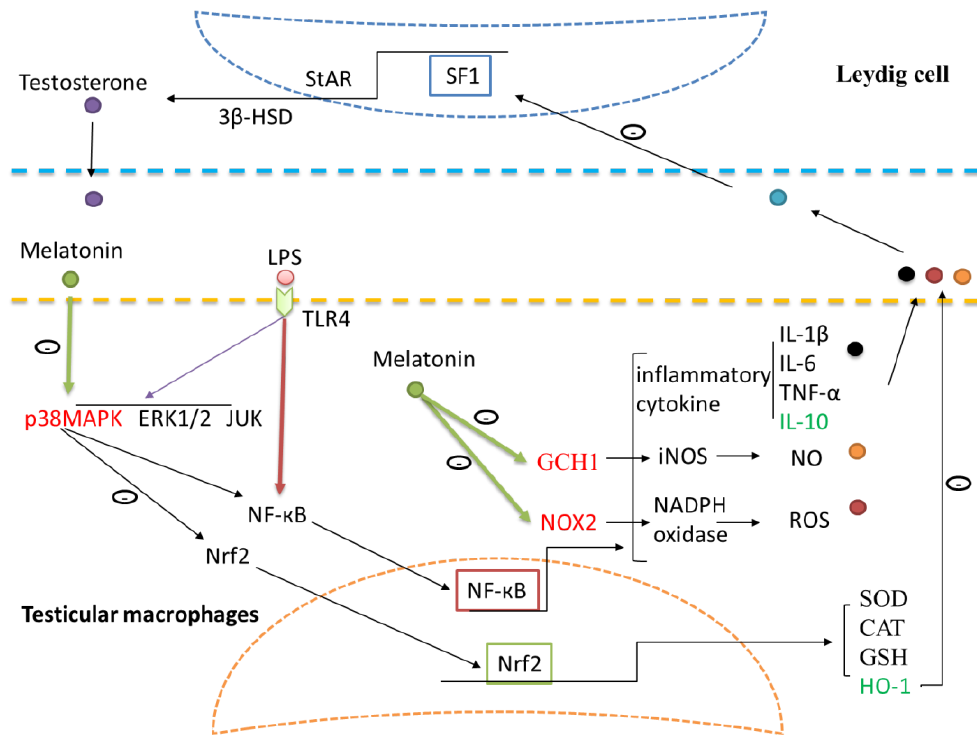
Figure 9. Schematic illustration of the proposed pathways by which melatonin regulates testosterone production and protects the testicular tissue from oxidative damage in LPS-induced sheep orchitis. Melatonin inhibited NF-кB through p38MAPK pathways in testicular macrophages. Expressions of GCHI and Nox2 were reduced by melatonin while HO-1 expression was up-regulated. Toll like receptors 4 (TLR4), nuclear factor kappa B (NF-кB), superoxide dismutase (SOD), catalase (CAT), glutathione (GSH), interleukin (IL), tumor necrosis factor alpha (TNF- α ), heme oxygenase-1 (HO-1), 3β-hydroxysteroid dehydrogenase (3β-HSD), steroidogenic factor 1 (SF1), steroidogenic acute regulatory protein (StAR), nitric oxide (NO), Guanosine triphosphate cyclohydrolase I (GCHI), nitric oxide synthetase (iNOS), Reactive oxygen species (ROS), nicotinamide adenine dinucleotide phosphate (NADPH) oxidase, NADPH oxidase 2